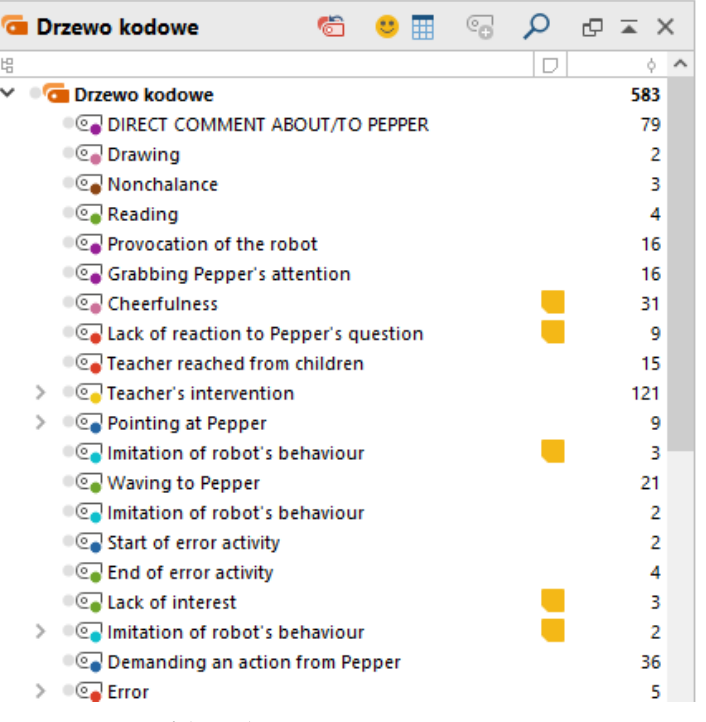
Figure 2. A part of the coding